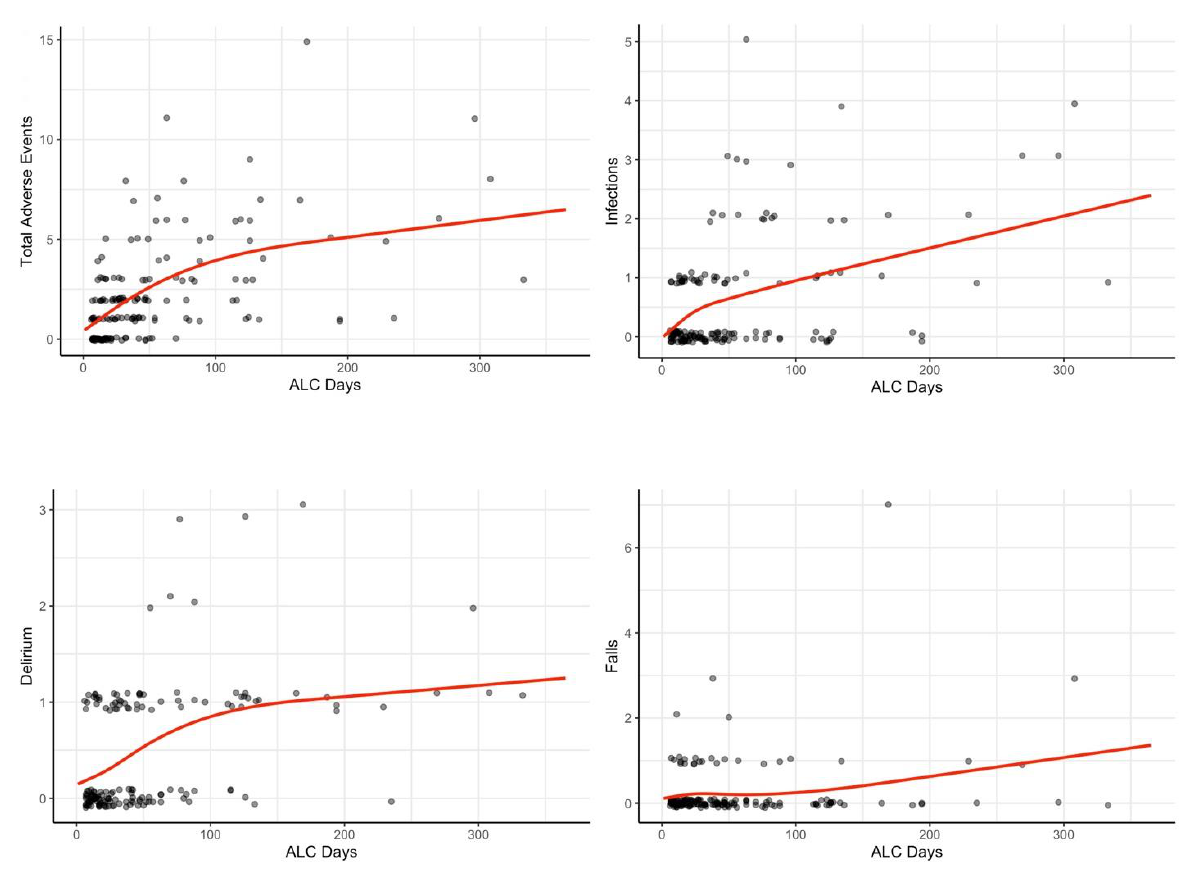
Figure 1. Descriptive modelling of expected healthcare-associated adverse events in study population as a function of ALC days using restricted cubic spline.